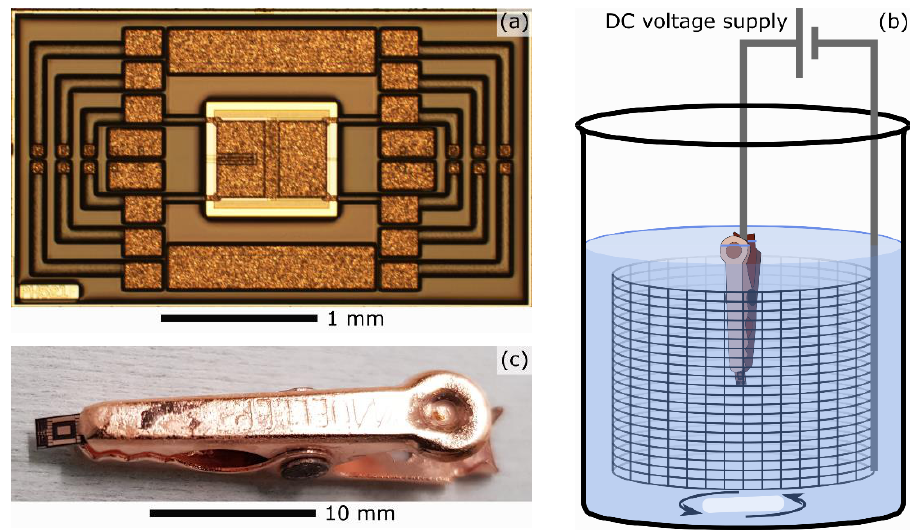
Figure 1. ( a ) Light microscopy image of a poly-heater. ( b ) Schematic diagram of the electropolishing setup and ( c ) an alligator clip electrically contacting a poly-heater for electropolishing.